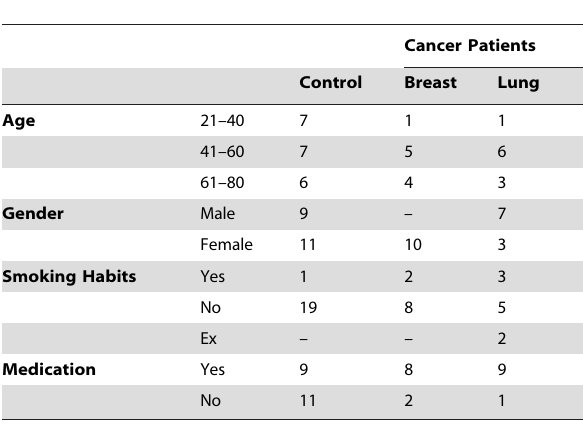
Table 1. The characteristics of subjects (Age, Gender, Smoking habits, Medication).